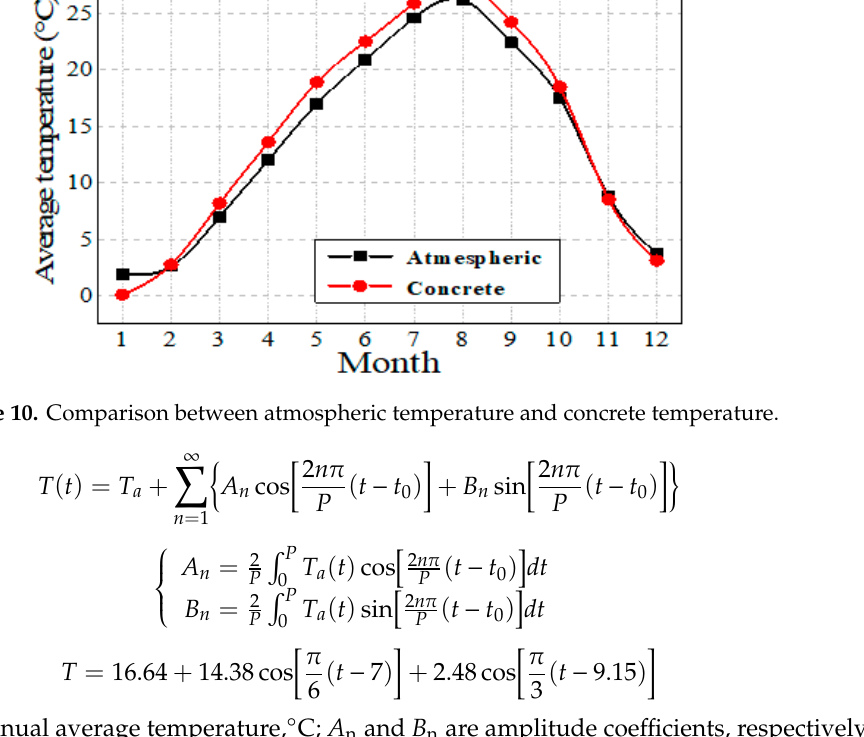
Figure 8. Variation of stress applied on reinforced bars with time.